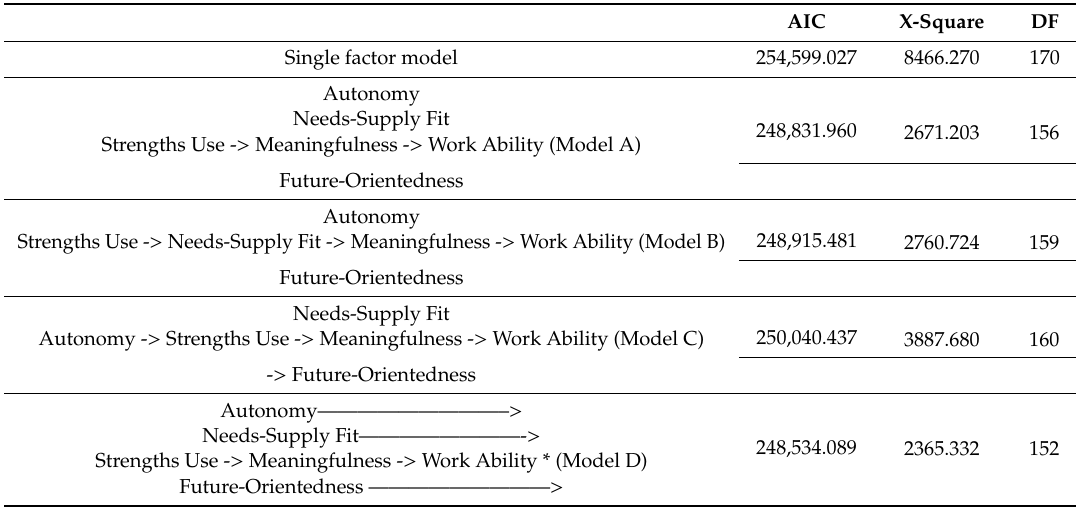
Table 2. Comparison of di ff erent